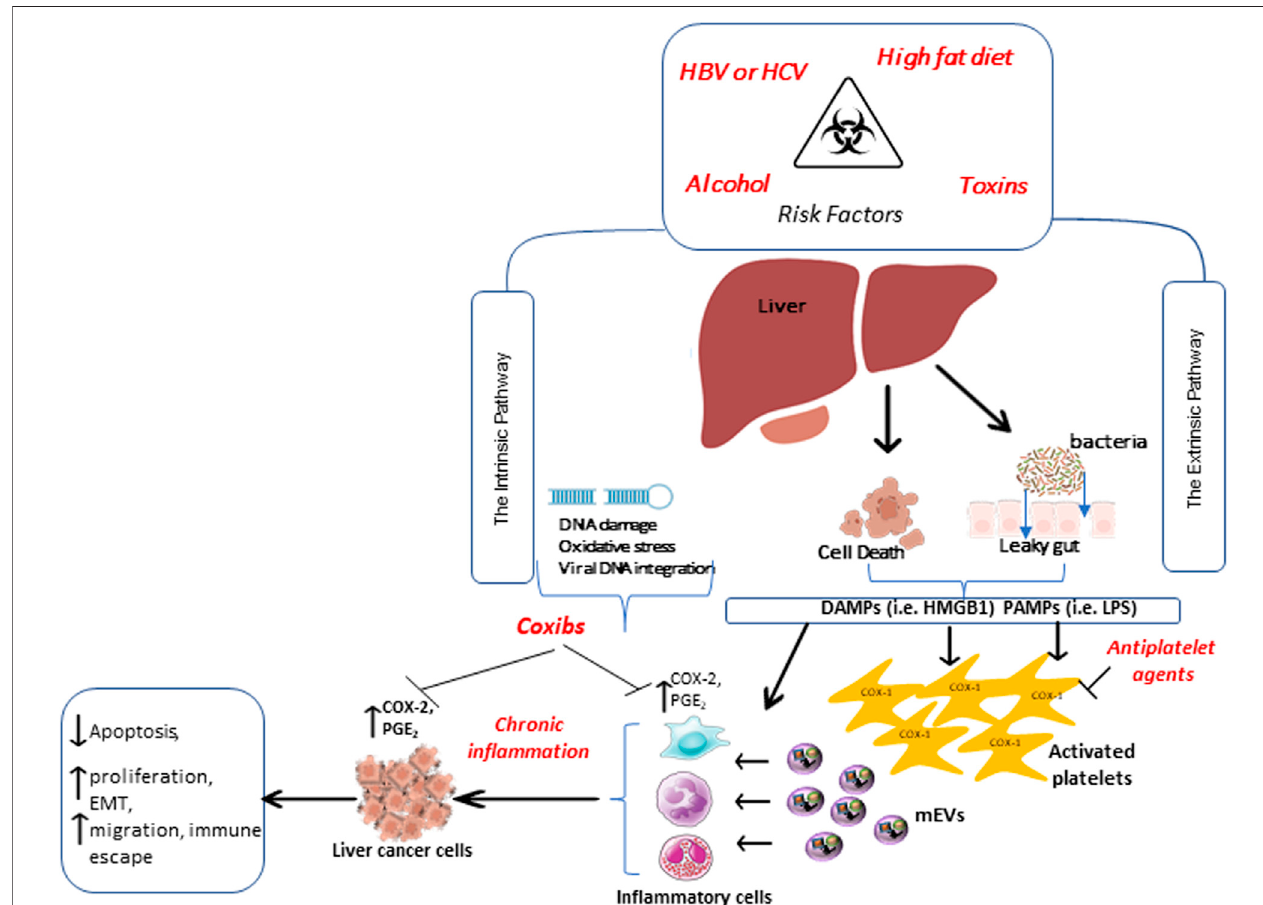
FIGURE 4 | Extrinsic and intrinsic pathways promote chronic in fl ammation involved in developing hepatocellular carcinoma. Two distinct pathways are involved in chronicin fl ammation during hepatocarcinogenesis. Theextrinsic pathway istriggeredbyexogenousfactors, such aspathogen-associated molecular patterns (PAMPs) or damage-associated molecular patterns (DAMPs) from dying cells. These, in turn, are recognized by speci fi c receptors expressed in in fl ammatory cells and platelets. PAMPs and DAMPs activate platelets, which release medium-sized extracellular vesicles (mEVs) able to exit the vasculature, reach tissues, and sustain in fl ammation, thus increasing cancer risk. The intrinsic pathway, induced by alteration in cancer-associated genetic factors, activates the expression of in fl ammation- relatedprograms, thus contributingtothe generation and perpetuationofan in fl ammatory milieu.All theseevents furthercontribute tothe overexpressionofCOX-2 and enhanced PGE 2 biosynthesis, promoting the transformation of normal epithelial cells to cancer. Antiplatelet drugs, such as low-dose Aspirin, can affect the early step of tumor development by inhibiting platelet function. In contrast, selective COX-2 inhibitors (coxibs) may exert an antitumor effect by inhibiting the synthesis of PGE 2 in leukocytes and tumor